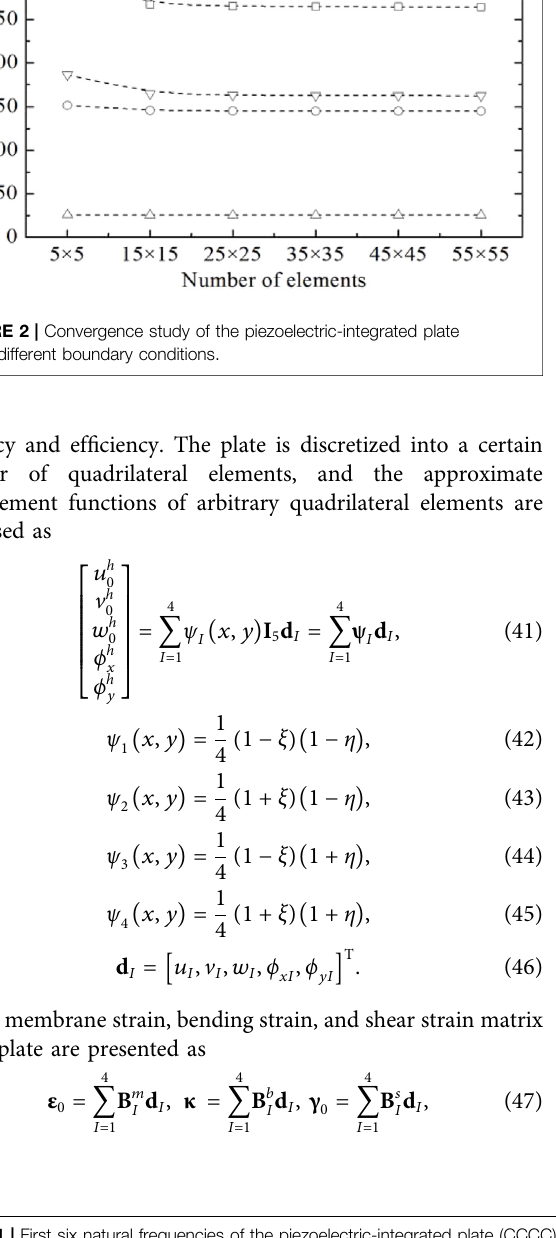
TABLE 1 | First six natural frequencies of the piezoelectric-integrated plate (CCCC). Mode